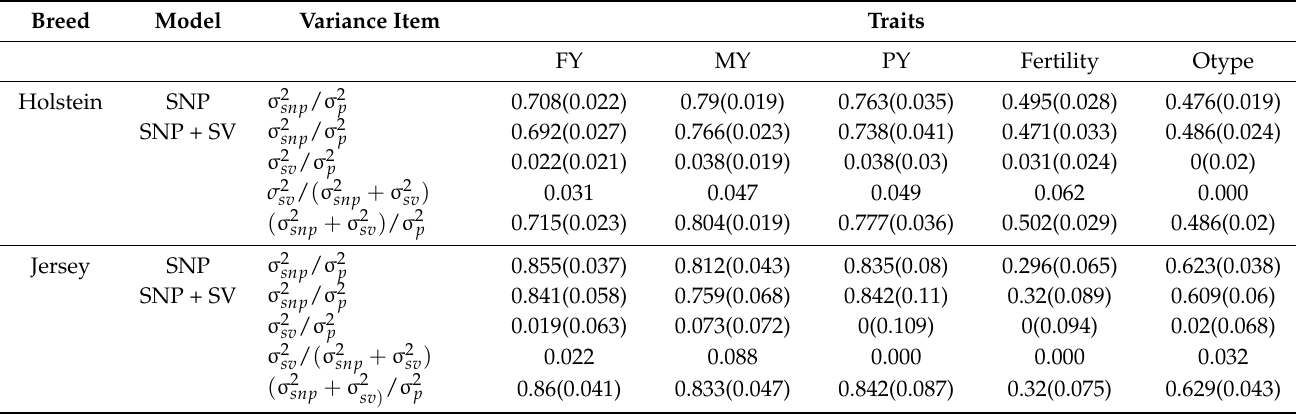
Table 3. Proportion of SNP and SV variances of total genetic variance and phenotypic variance for milk (MY), fat (FY), protein yield (PY), fertility and overall type (Otype) in Holstein and Jersey bulls.